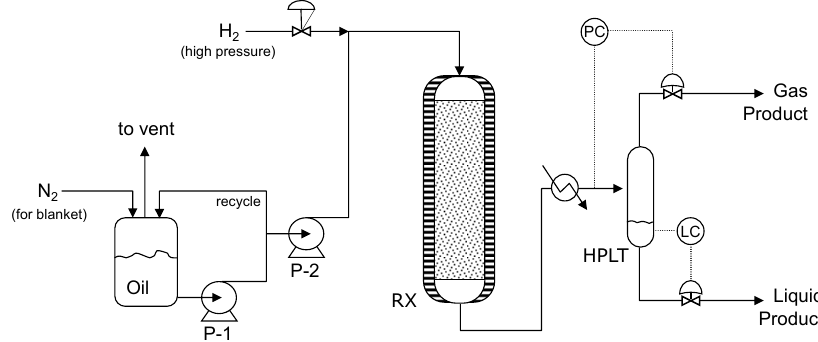
Figure 3. Simplified schematic diagram of the catalytic hydroprocessing pilot plant of the Centre for Research and Technology Hellas (CERTH) employed for the conversion of the pyrolysis oil mid-distillate fraction to diesel. RX: Reactor, HPLT: high pressure low